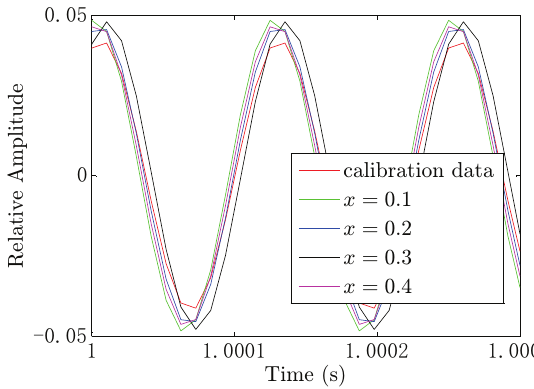
Figure 18. The calibration data and the measured voltages when the target is situated at points ( x ,0,0.1 ) for the first receiving channel.